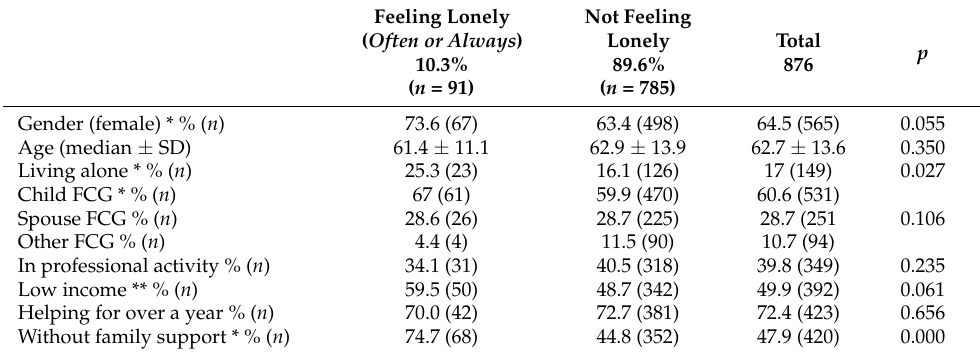
Feeling Lonely ( Often or Always )